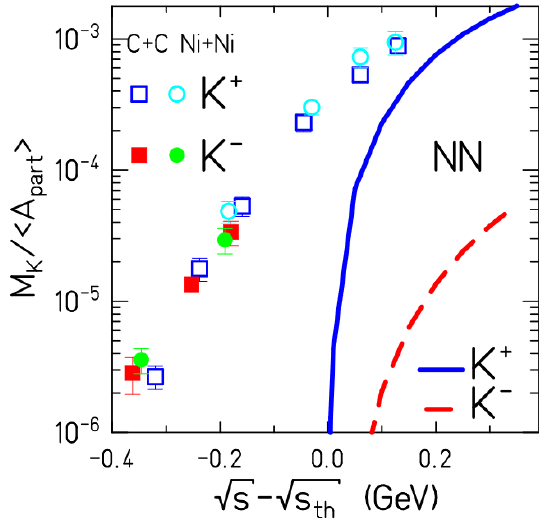
Figure 7. K + and K − multiplicity per number of participating nucleons as a function of the available energy above threshold in first-chance collisions for C+C and Ni+Ni collisions (for symbols, see legend) and parameterizations of the kaon production cross sections in nucleon–nucleon collisions (for lines, see insert). Taken from [40].